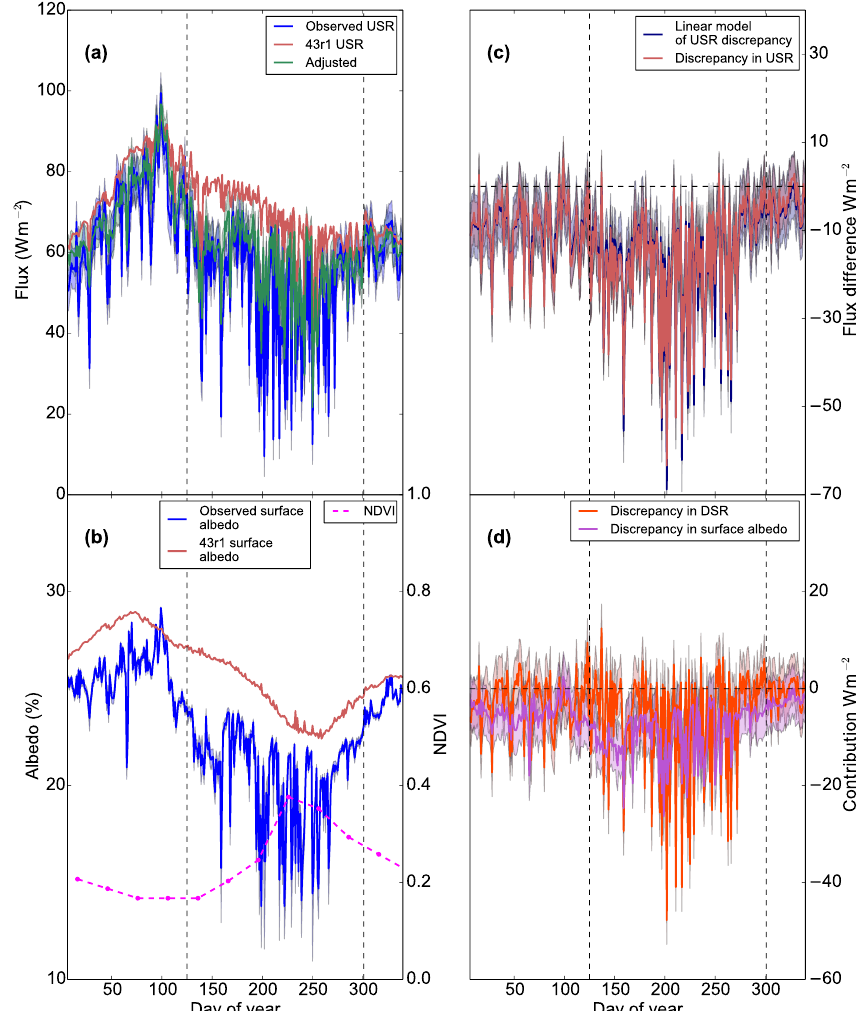
Figure 8. Plot (a) shows observed USR (blue), 43r1 USR (red) and “adjusted” USR (calculated from 43r1 DSR and observed surface albedo, green). Plot (b) shows inferred surface albedo as calculated by the ratio USR/DSR from the observations (blue) and 43r1 (red), as well as NDVI (see text). Plot (c) shows USR discrepancy (red) and linear model (blue) of USR discrepancy with contributions in plot (d) from discrepancy in surface albedo (pink) and DSR discrepancy (orange). Dashed lines indicate the beginning and end of the wet